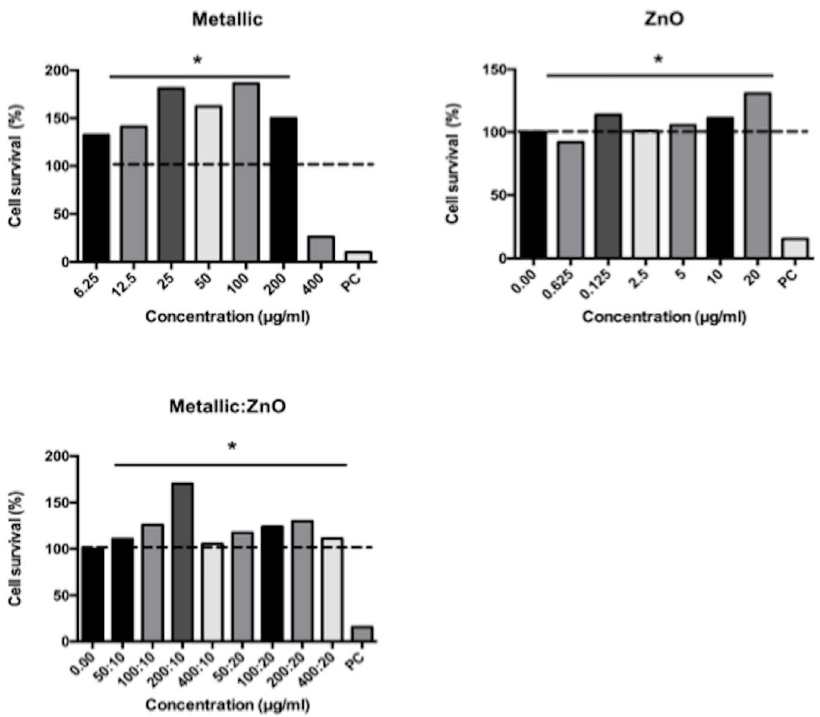
Fig 5. Cytotoxic activity of ZnO- and metallic-NPs exposed to human macrophages. The cell survival (%) was normalized to the untreatedcell values. PC = positive control. The dashedline represents 100%cell survival. The significancewas comparedto the positive